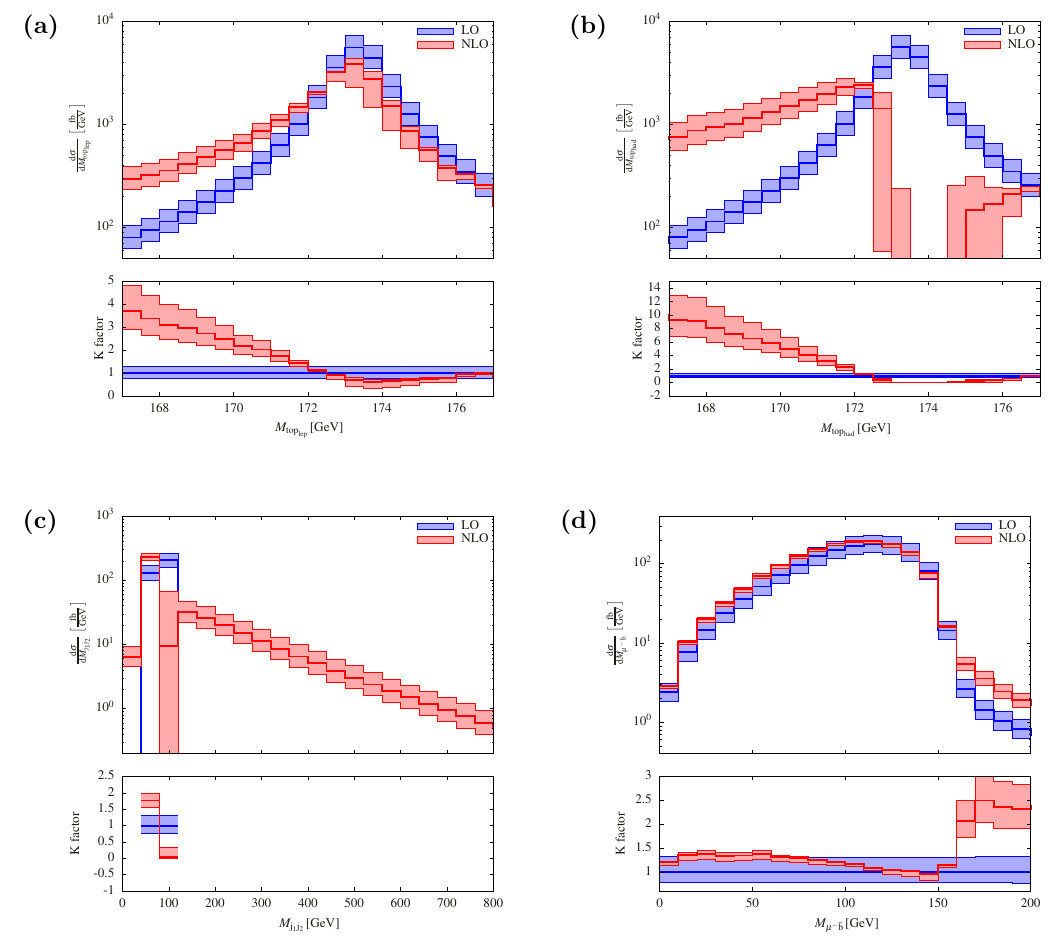
Figure 6. Di(cid:11)erential distributions at a centre-of-mass energy p s = 13 TeV at the LHC for pp (cid:22) (cid:0) (cid:22) (cid:23) (cid:22) b(cid:22)bjj: (a) invariant mass of the leptonic top quark (top left), (b) invariant mass of ! the hadronic top quark (top right), (c) invariant mass of the two hardest jets (bottom left), and (d) invariant mass of the muon and anti-bottom quark (bottom right). The upper panels show the LO prediction as well as the NLO one. The lower panels display the ratio of the NLO and the LO predictions. The bands correspond to factor-2 scale variations as de(cid:12)ned in eq. (4.9).